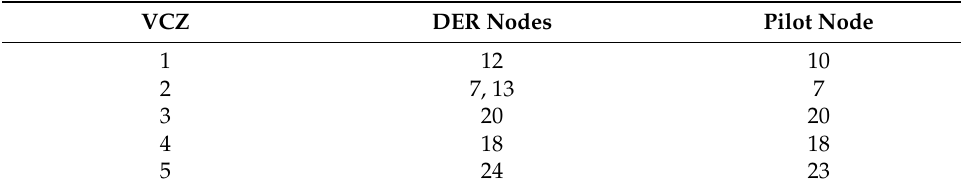
Table 2. DER nodes and Pilot Nodes allocation in the 5 VCZs. VCZ DER Nodes Pilot Node 1 12 10